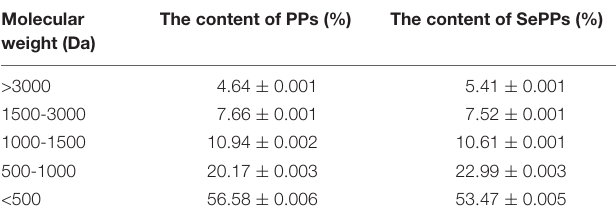
TABLE 2 | Molecular mass distribution of PPs and SePPs. Molecular weight